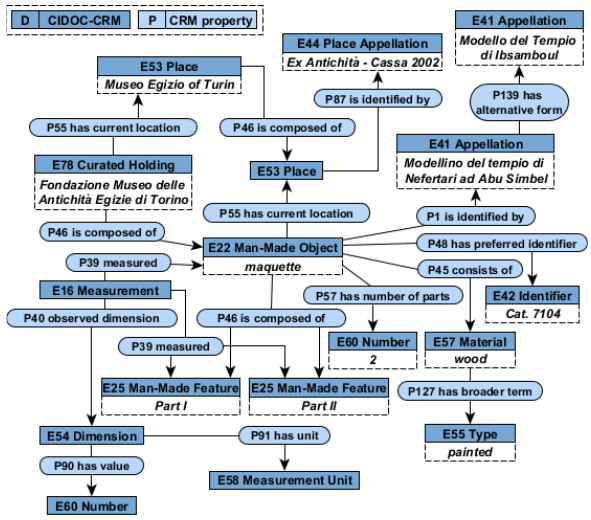
Figure 3. Graph representing new fields available and their CIDOC-CRM reference classes and properties